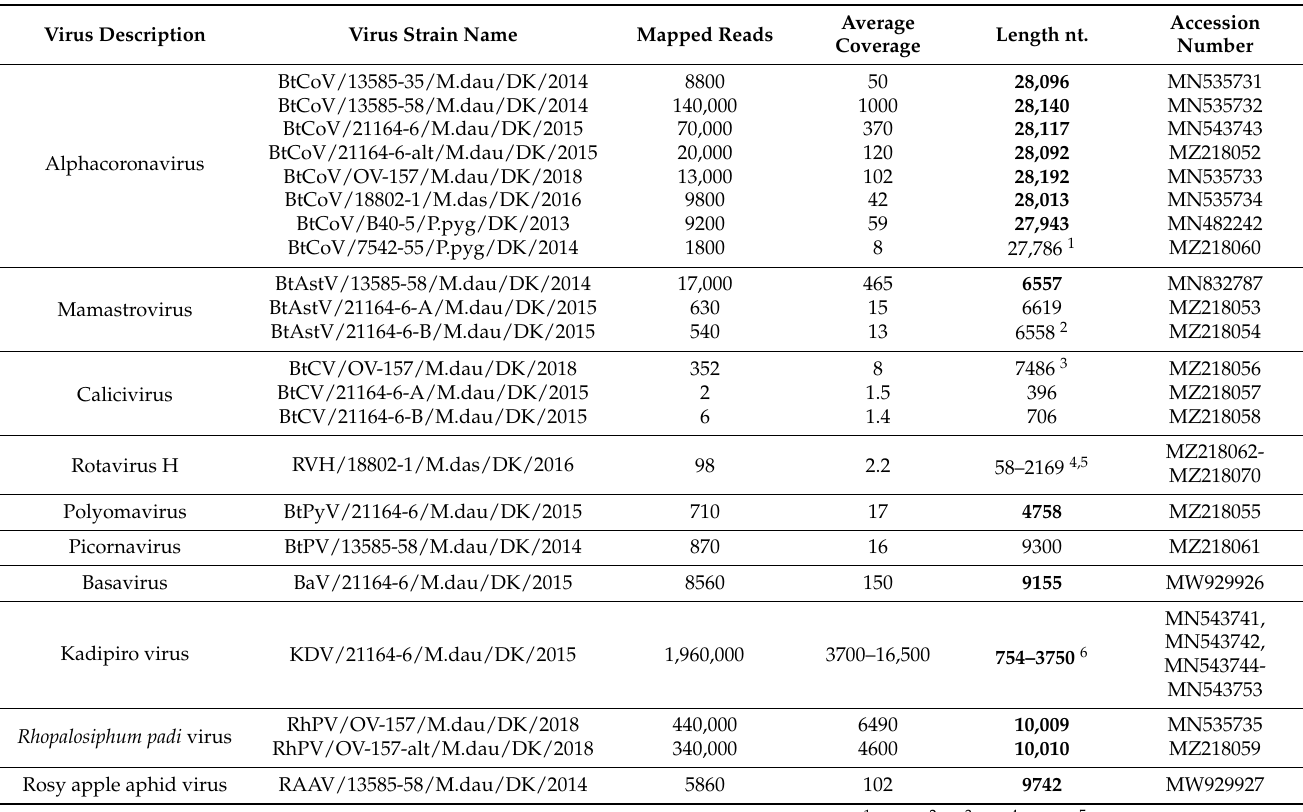
Table 3. ist of all full-length (highlighted in bold) and partial genome sequences assembled in this study and deposited in